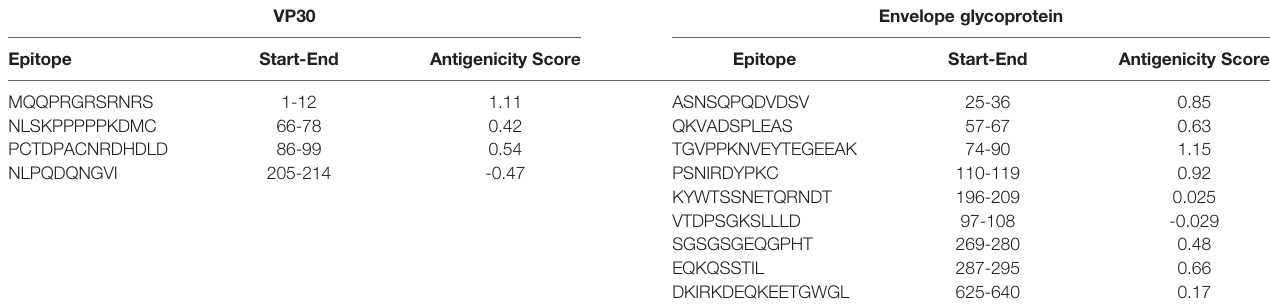
TABLE 1 | Predicted B cell epitopes from VP30 and envelope glycoprotein. VP30 Envelope